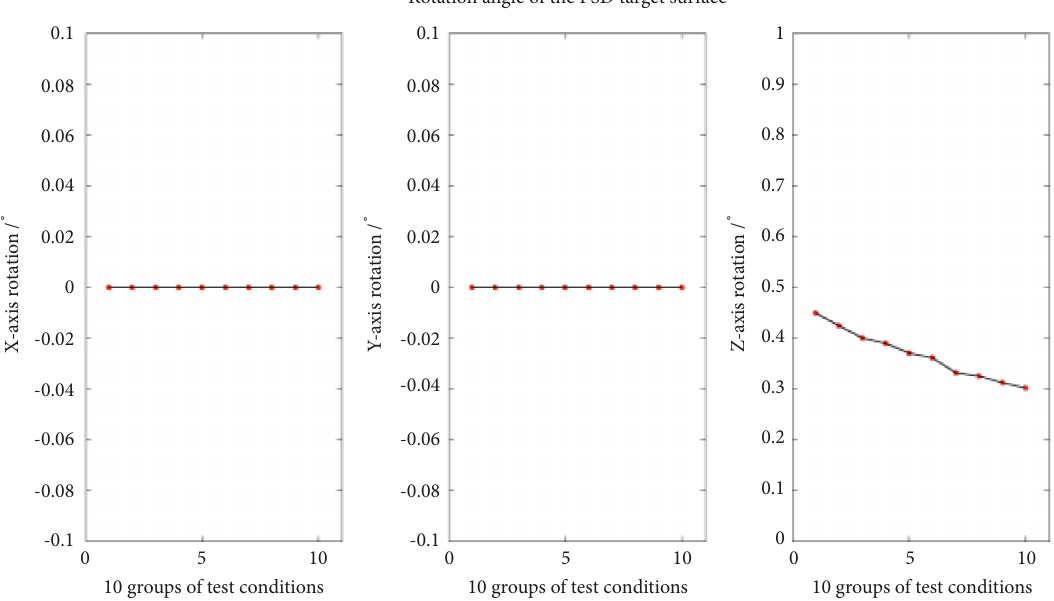
Figure 17: Results of the last 10 groups of change in the 3-DOF PSD